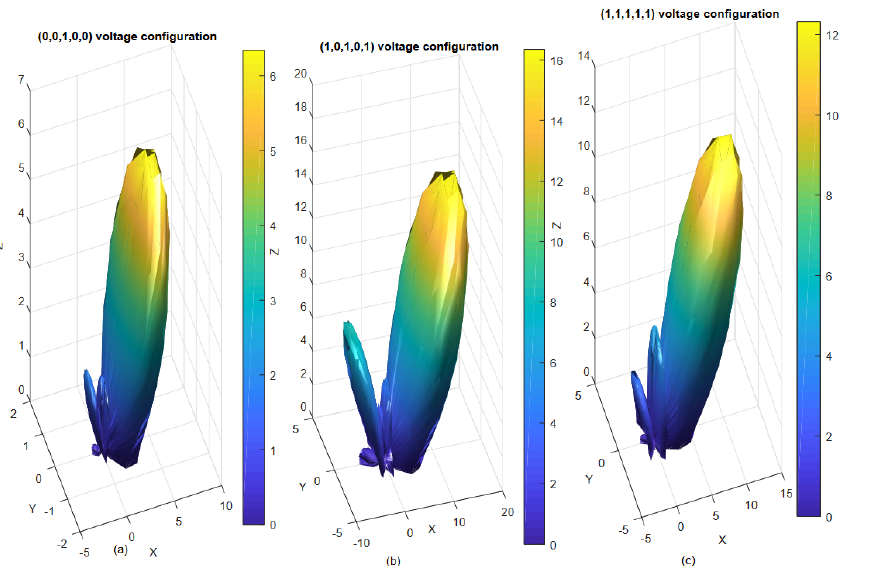
Figure 22. 3D Electronically scanned radiation pattern examples for distinct aperiodic array configu- rations compared to the periodic array obtained using the electromagnetic calculation (MoM-GEC method): φ s = 0 ◦ , θ s = 45 ◦ angles of steering: ( a ) An aperiodic configuration of type (0,0,1,0,0), ( b ) An aperiodic configuration of type (1,0,1,0,1), ( c ) A periodic configuration of type (1,1,1,1,1)